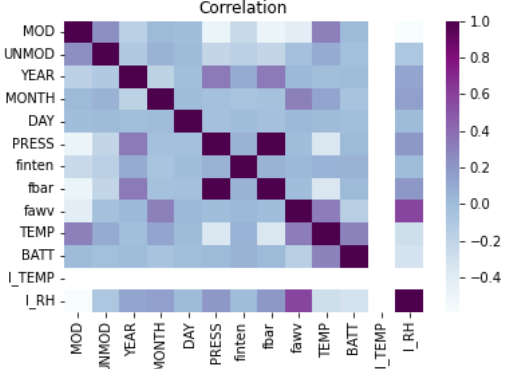
Figure B3. A correlation heat map is generated during quality analysis. We would expect correlation between certain variables (such as fbar and PRESS), but other correlations may point towards issues with the sensor that require